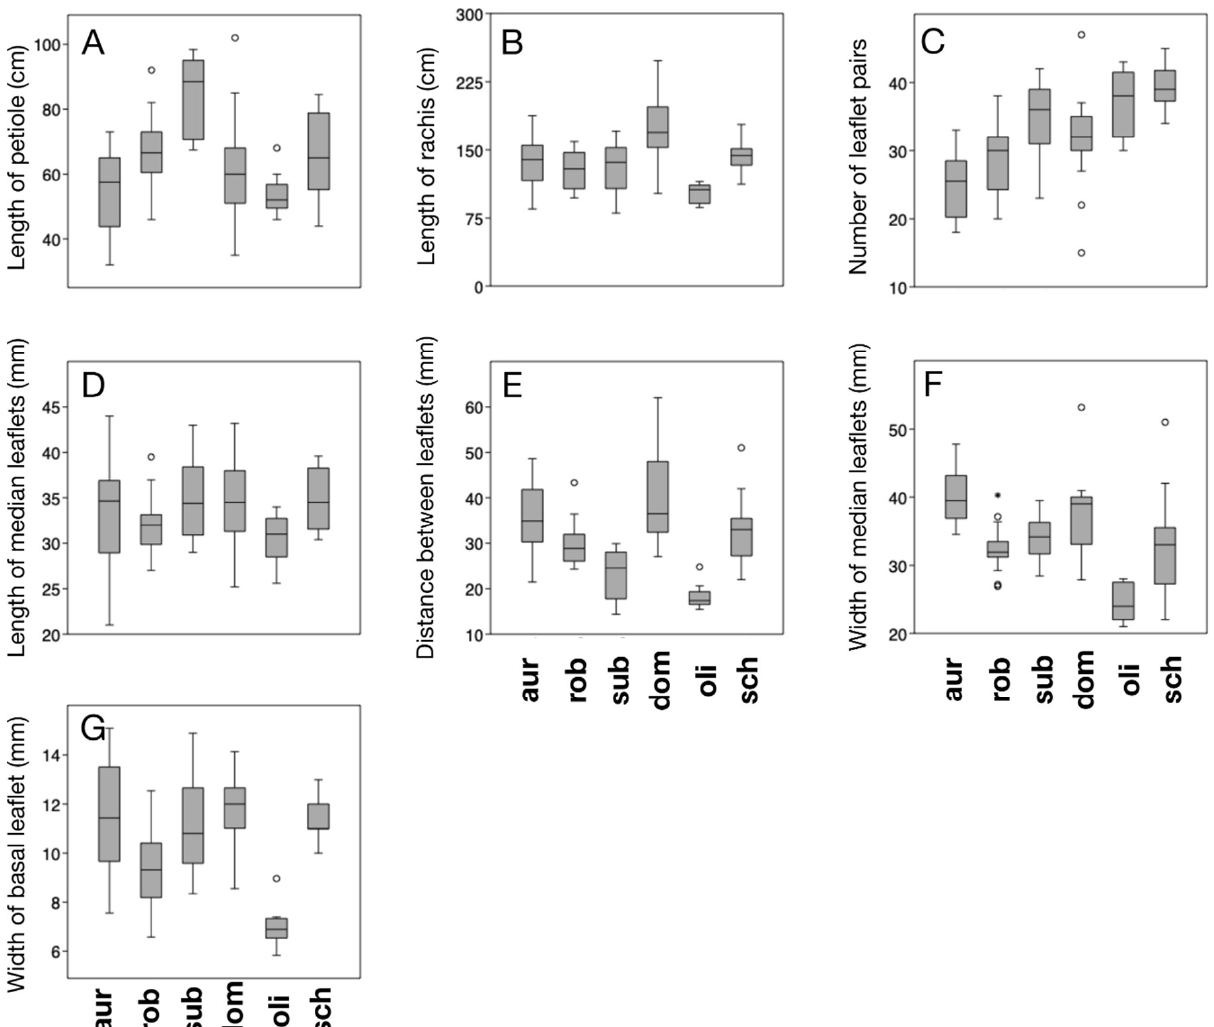
Figure 2. Morphometric variation among the six species in the Ceratozamia robusta species complex analyzed in this study: Ceratozamia aurantiaca (aur), C. robusta (rob), C. subroseophylla (sub), C. dominguezii (dom), C. oliversacksii (oli), and C. schiblii (sch). The order of plots corresponds to the traits ( A–G ) listed in Table 3. Whiskers indicate standard error and circles indicate outliers.